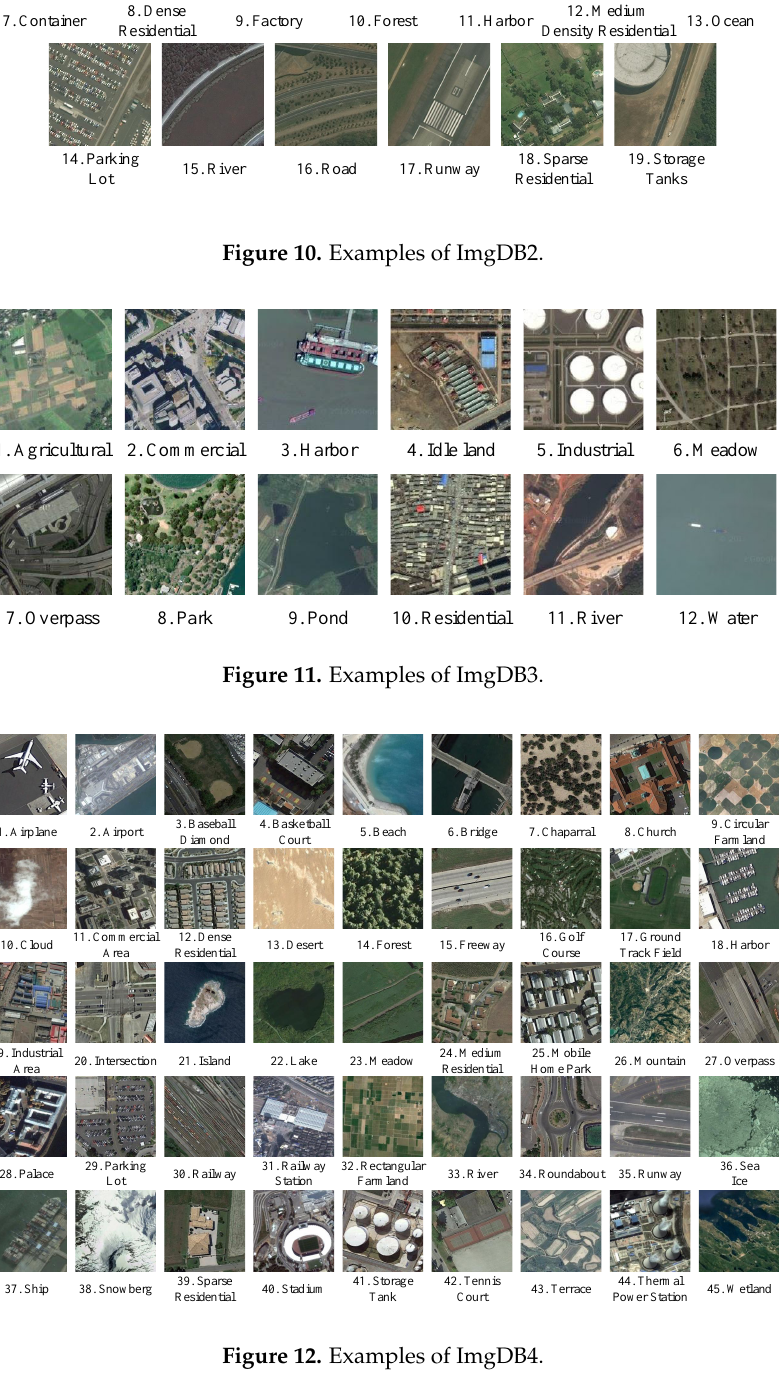
Figure 12. Examples of